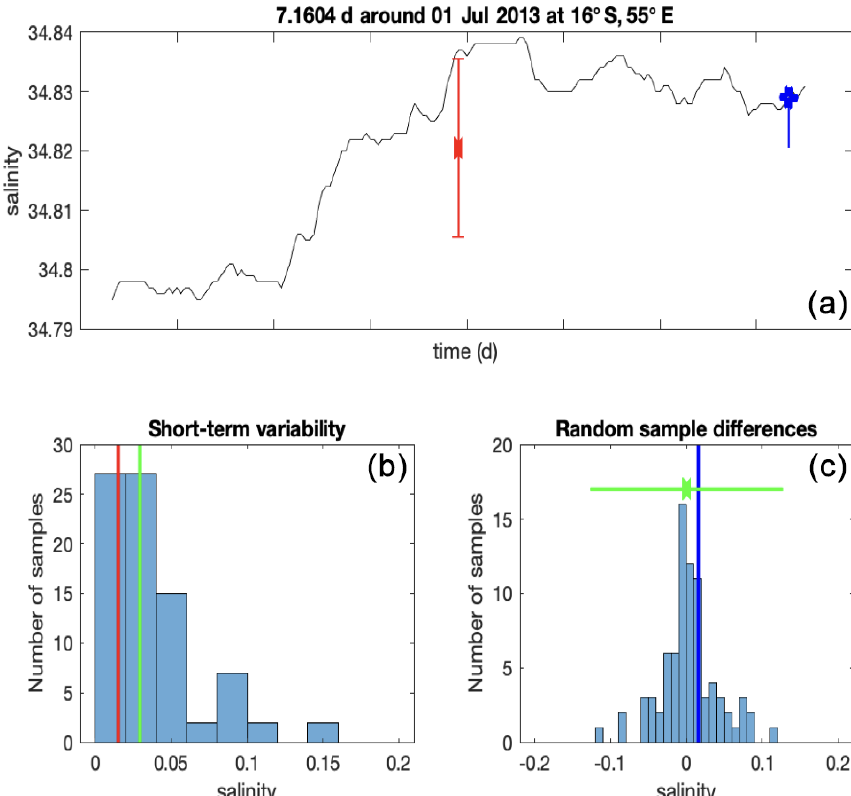
Figure 3. An example of how the STV is computed, as explained in the text. (a) A ∼ 7d piece of the SSS record from the indicated mooring. The mean value is shown by the red mark, with the red bars representing ± 1 standard deviation. The blue “+” is a random value picked from the record. The blue line shows the difference between the random value and the mean value. (b) The distribution of STV from the entire record at this mooring. One value is given by the standard deviation from panel (a) and is the same as the red bar in panel (b) . The median of the values in this distribution is indicated by the green bar. This is the single number from this mooring that is shown as STV in Fig. 3a. (c) Distribution of differences between random samples and mean values. One value is given by the blue line in panel (a) and is the same as the blue bar in panel (c) . The RMS of this distribution is shown by the green bars, which is the mean ± RMS. These bars are the single RE value that is shown for this mooring in Fig.